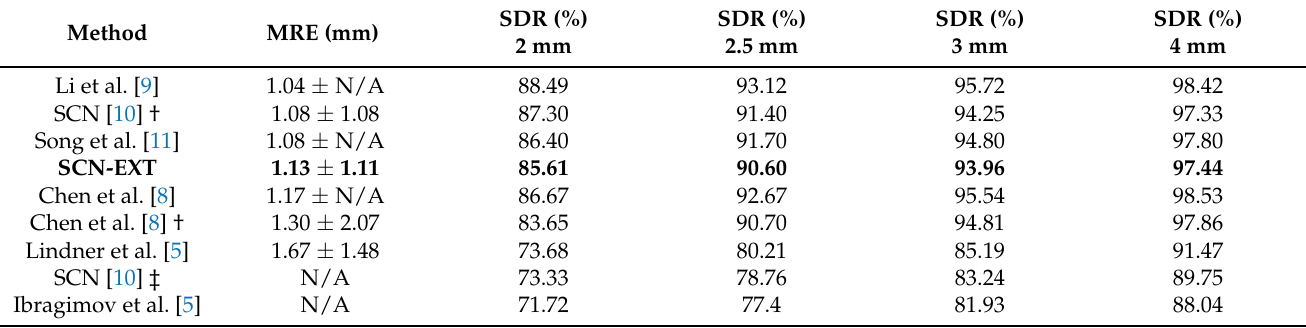
Table 4. Effectiveness of cephalometric landmark detection methods on the public ISBI database: testing set 1. The column MRE denotes the mean and standard deviation of the radial error, while the SDR columns denote the successful detection rate (in %) for the four specified